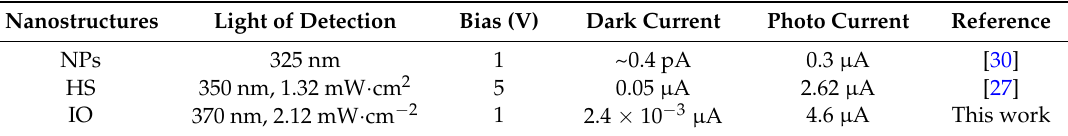
Table 2. Representative results of ZnO nanostructures with different shapes, and their corresponding UV photodetector performances. NPs: nanoparticles; HS: hollow-sphere; IO: inverse opal. Nanostructures Light of Detection Bias (V) Dark Current Photo Current Reference NPs 325 nm HS 350 nm, 1.32 mW · cm